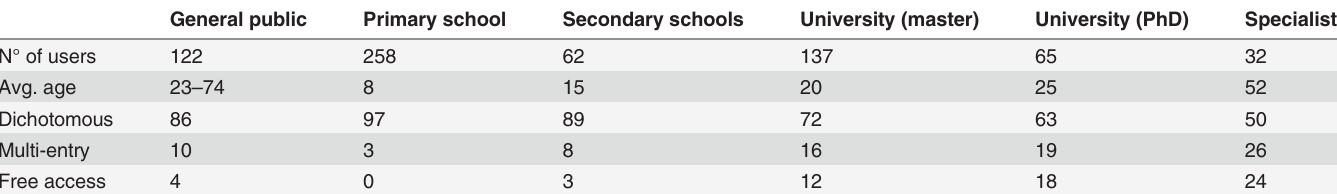
Table 2. Preference of different categories of users among three different types of identification interfaces (in